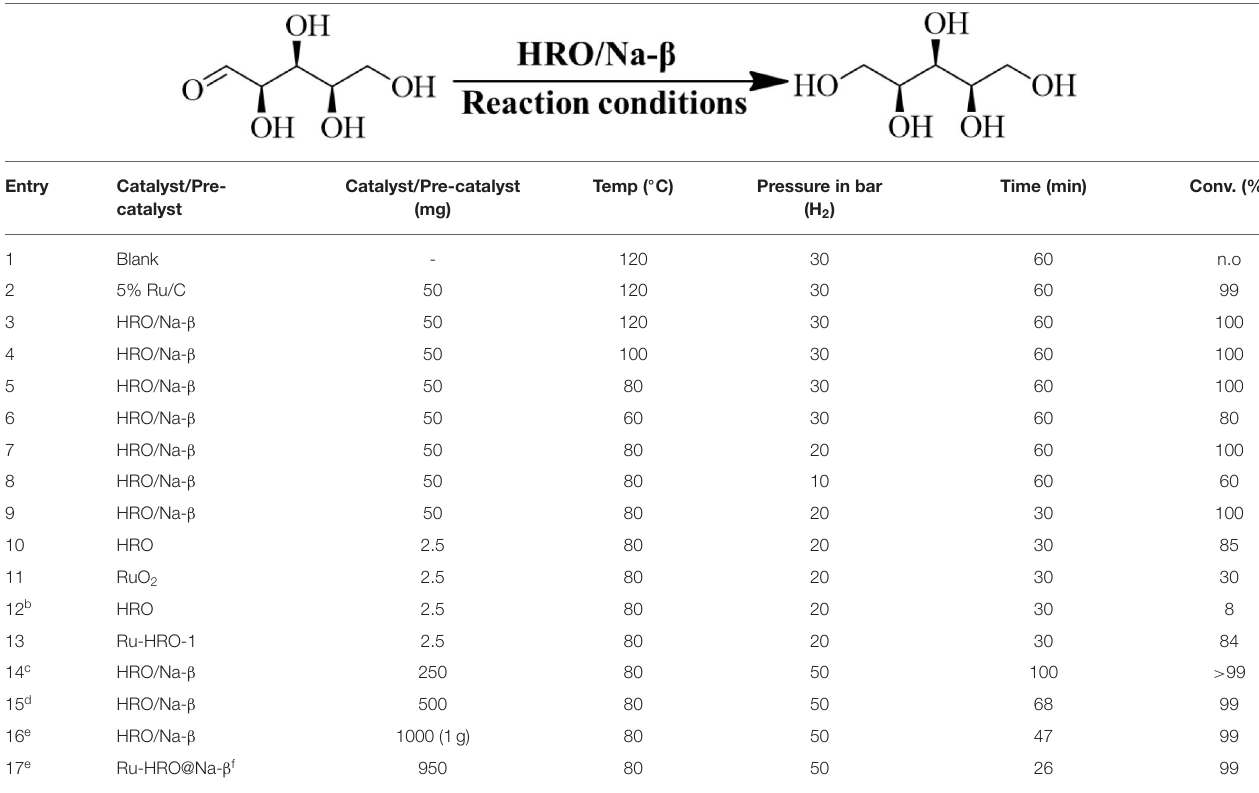
TABLE 1 | Catalyst screening and optimization reaction condition for the hydrogenation of xylose to xylitol a .